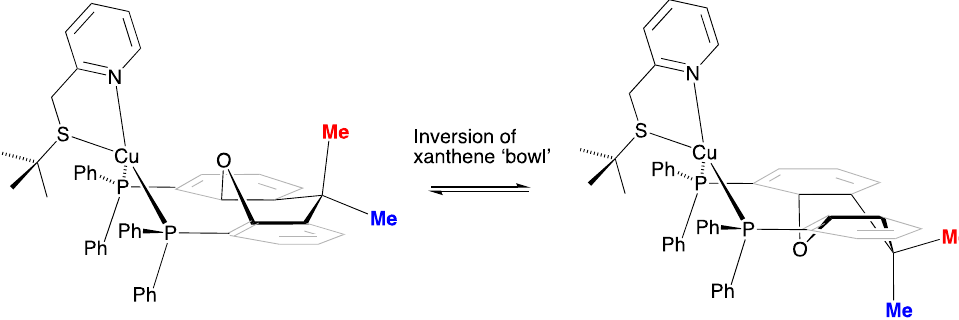
Figure 8. EXSY cross-peaks in the alkyl region of the ROESY spectrum of [Cu(xantphos)( t BuSPy)][PF 6 ] (500 MHz, acetone- d 6 , 198 K). Major species represented by black labels, minor by red labels.